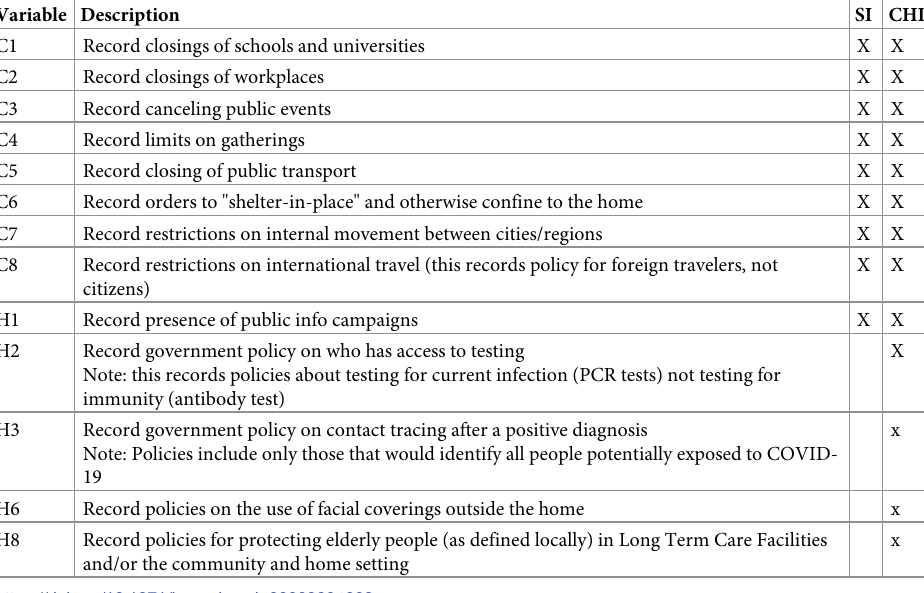
Table 2. Non-pharmaceutical policy variables used in OxCGRT index